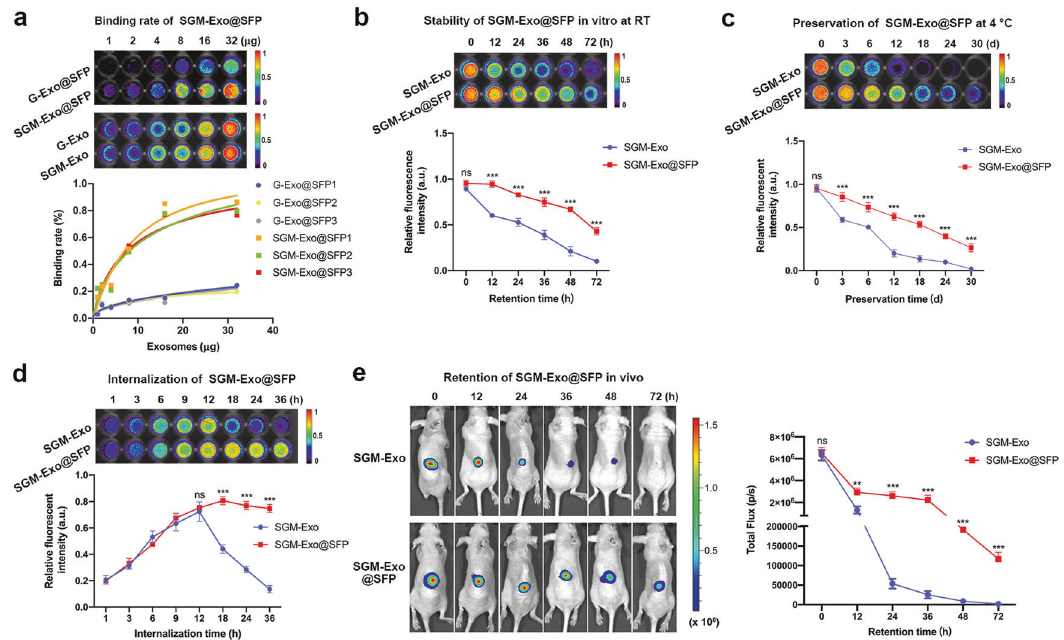
Fig. 3 SFP enhanced the binding rate, release sustainability, and stability of SGM-Exos. a The binding rate of SGM-Exos with SFP was signi fi cantly higher than that of G-Exos ( n = 6/group). b SFP enhanced the stability of SGM-Exos at RT ( n = 8/group). c SFP enhanced the stability of SGM-Exos at 4 °C ( n = 8/group). d Internalization of SGM-Exos released from SFP by HaCaT cells ( n = 8/group). e Retention of SGM- Exo and SGM-Exo@SFP in vivo monitored by Gaussia luciferase (Gluc) activity ( n = 6/group). The signal activity was expressed as photons/s/ cm 2 /steradian (sr). Data represent the mean ± S.D. of three different experiments (ns: no signi fi cance, ** p < 0.01, *** p <